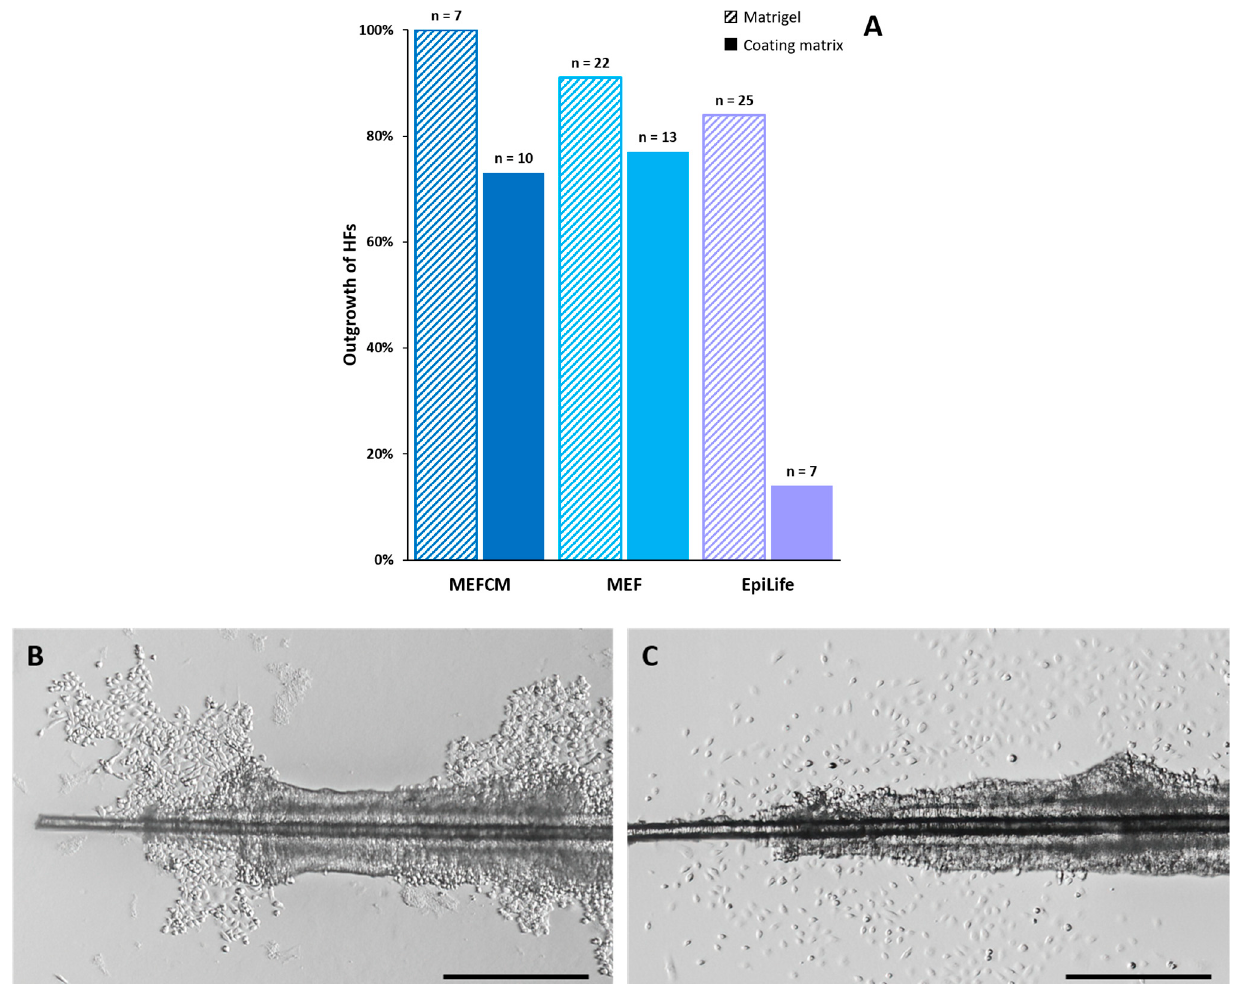
Figure 6. Growth behavior of keratinocytes on different coating solutions. ( A ) Relative primary outgrowth of HFs in different media (MEFCM, MEF medium, EpiLife medium) and coating conditions (Matrigel, collagen I coating matrix). ( B ) Representative DIC image of the distal part of an HF with confluent keratinocytes growing on a 1:10 diluted Matrigel coating after 9 days of cultivation. ( C ) Distal part of an HF with scattered keratinocytes outgrowing on the coating matrix kit after 9 days of cultivation. N = number of single, independent experiments. Scale bar: 500 µm.